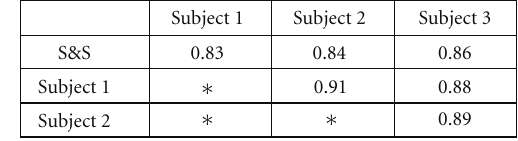
Figure 14: Table of DSC values comparing segmentations produced by 3 independent subjects and our Shells and Spheres